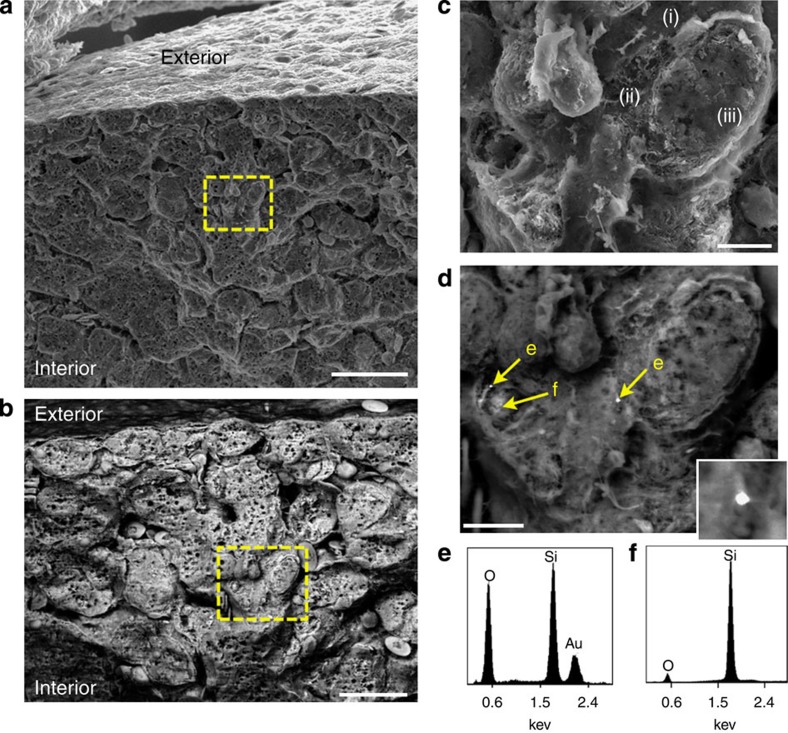
Chemical fingerprinting of gold nanoparticles in the interior of a chicken liver.A mechanically fractured silica bioreplicated and carbonized (c-SBR) chicken liver imaged using secondary electron (SE) (a, scale bar, 50 μm) and backscattered electron detection (BSE) (b, scale bar, 50 μm) reveals gross morphology of the internal liver. The area within the dashed rectangle in a and b is expanded and imaged using SE (c, scale bar, 5 μm) revealing a fenestrated sinusoid (i), space of disse (ii) and hepatocyte (iii). This same region is imaged using BSE to reveal single 200-nm diameter AuNPs (d, scale bar, 5 μm; inset is a magnification of the centre bright spot). The spectrum in e was acquired from the centre particle (and representative of spectra obtained from other points denoted as ‘e’) and the spectrum in f was acquired from the region ‘f’ denoted in d. (e,f) Show relative intensities from single pixel acquisitions of >1,000 counts.